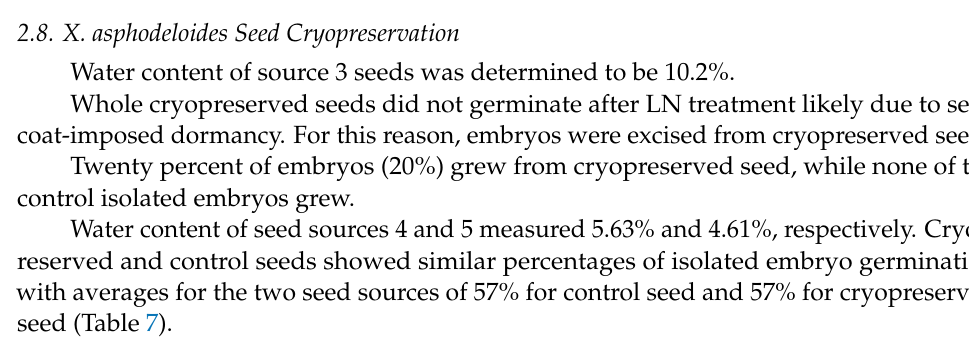
Table 7. Xerophyllum asphodeloides isolated embryo germination after 8 weeks for control and seed cryopreserved for one month.